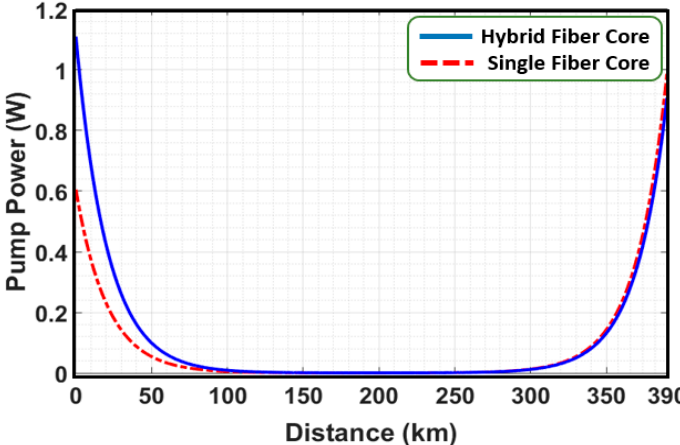
Figure 3. Pump power distribution of a bidirectional pumped distributed Raman amplification span for the three-segment hybrid fiber core structure compared to the conventional single fiber core structure over a propagation distance of 390 km.